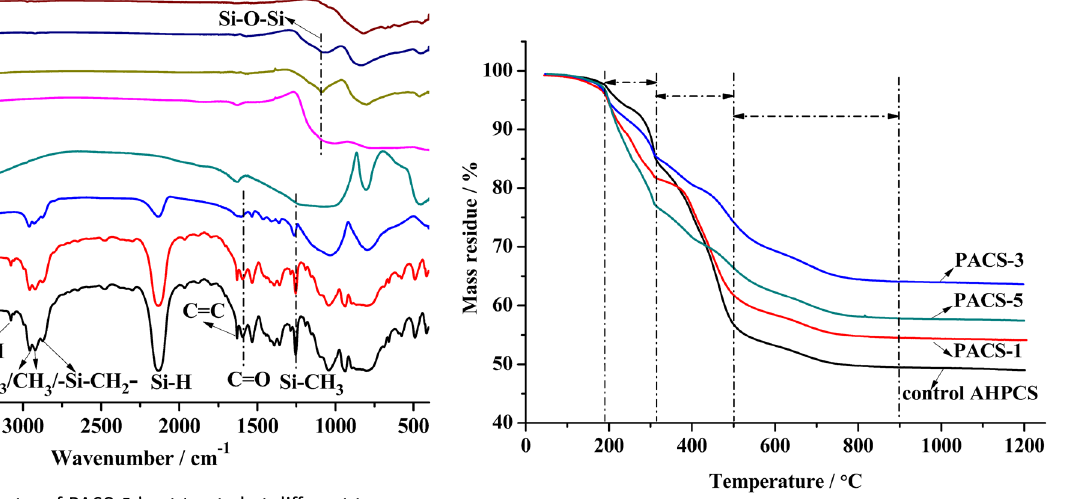
Figure 7: FT - IR spectra of PACS - 5 heat treated at di ff erent tem - peratures in Ar. Figure 8: TGA curves of the cured control AHPCS and